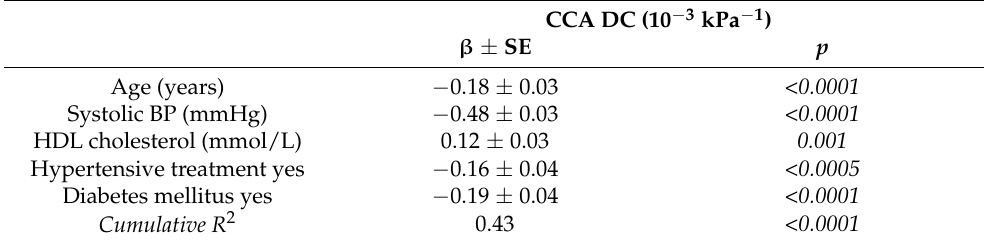
Table 4. Independent correlates of CCA distension